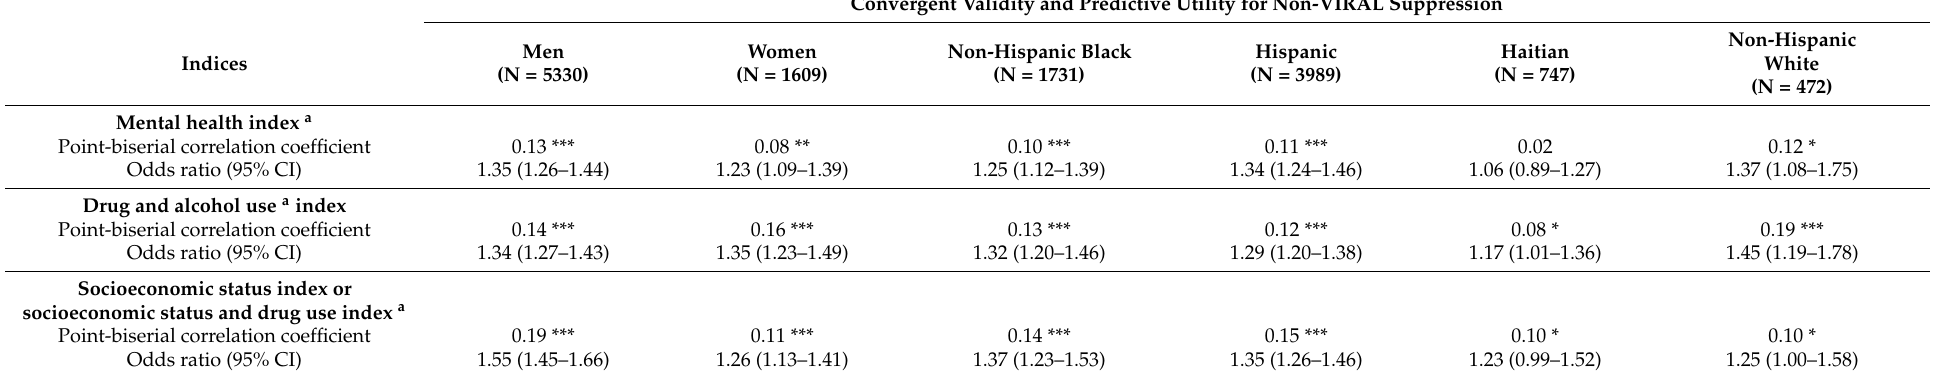
Table 3. Range of scores, convergent validity, and predictive utility for non-viral suppression of gender- and racial/ethnic-specific vulnerable/enabling indices for the Miami–Dade County Ryan White Program client